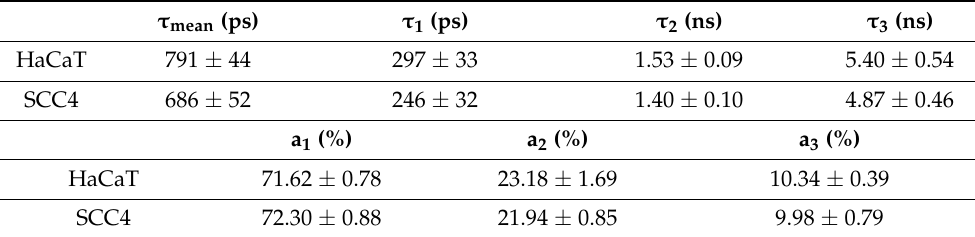
Figure 2. Intensity preview images obtained during lifetime measurements after two-photon excitation at 880 nm ( a ) and 780 nm ( b ) of HaCaT cells. Fluorescence was detected in the spectral range 426–446 nm (green channel) and 542–582 nm (red channel). Table 1. Fluorescence lifetime values ( τ i ) and their corresponding exponential coefficients (a i ) of flavins in HaCaT and SCC4 monocultures. The values were calculated by a three-exponential fit decay